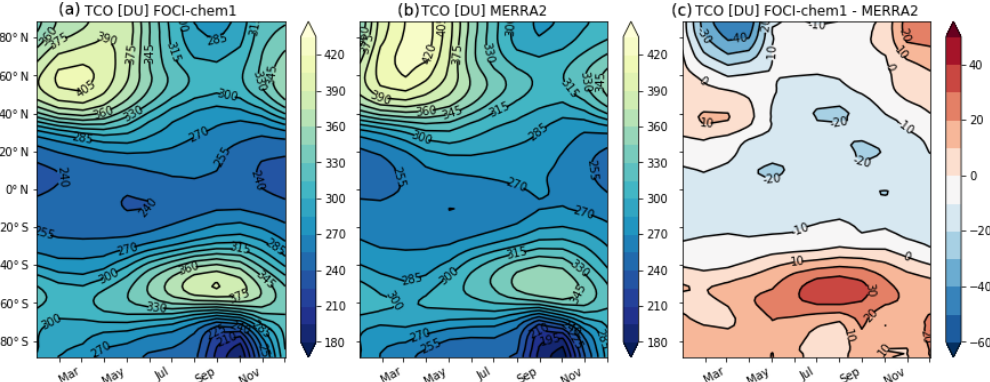
Figure 8. Zonal mean TCO climatology from (a) the FOCI-chem1 simulation, (b) the MERRA2 reanalysis (contour interval of 15 Dobson units; DUs) and (c) the differences between panels (a) and (b) from 1980 to 2013 (contour interval of 10